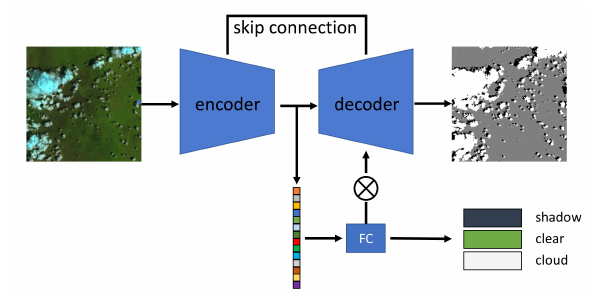
Figure 2. Flowchart of the proposed